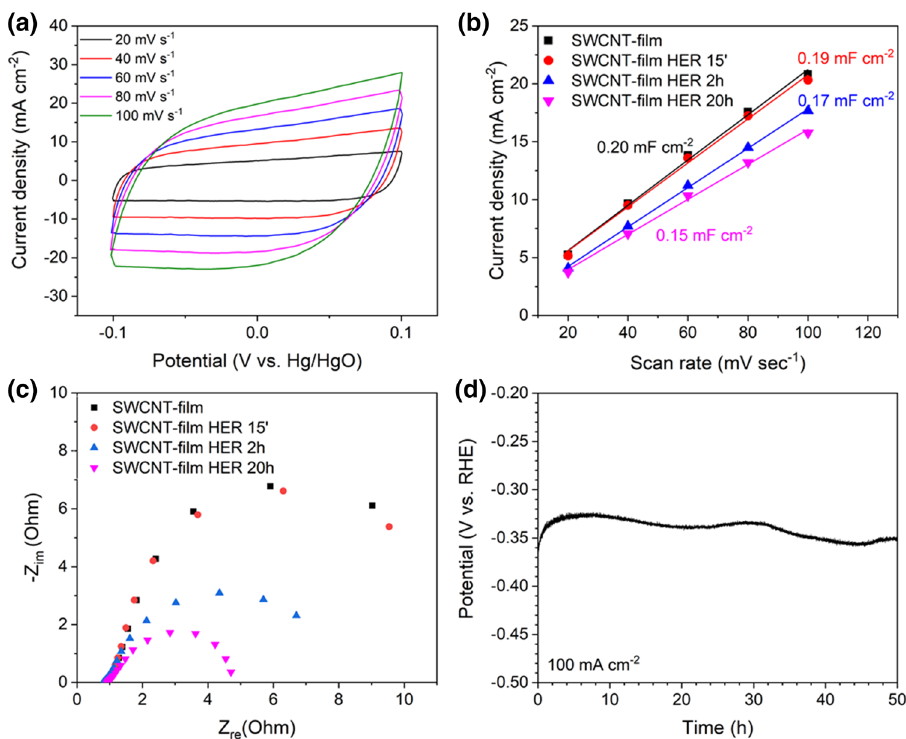
Figure 5. ( a ) Cyclic voltammetry plots at different scan rates for SWCNT film after 20 h of HER, ( b ) linear fits of current densities versus scan rates for freshly annealed SWCNT films and subjected to HER for 15 min, 2 h, and 20 h, ( c ) Nyquist plots for electrodes at different stages of activation at the overpotential of 275 mV, and ( d ) HER chronopotentiometry curve for SWCNT film after 20 h of HER at the current density of 100 mA cm −2